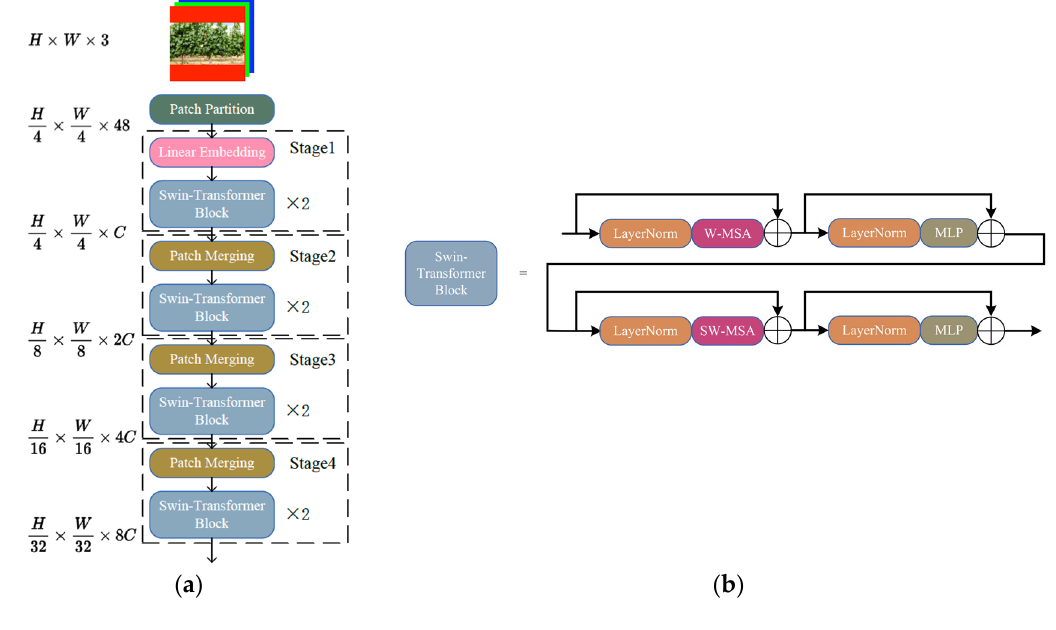
Figure 3. ( a ) Overall architecture of Swin-transformer (H and W refer to height and width of the images; C refers to the number of feature channels) and ( b ) two successive Swin-transformer blocks (W-MSA and SW-MSA refer to Window-based multi-head self-attention and shifted window-based MSA; MLP refers to multi-layer